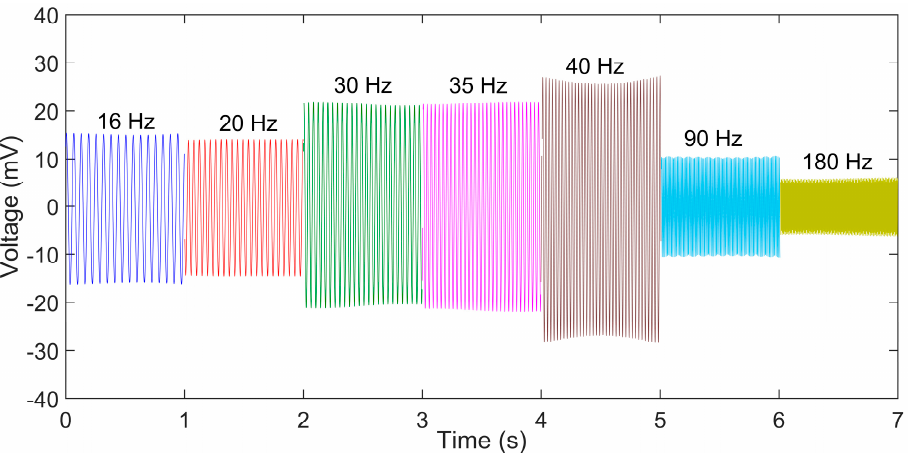
Figure 10. Sensor voltage output of the impact hammer on the string.